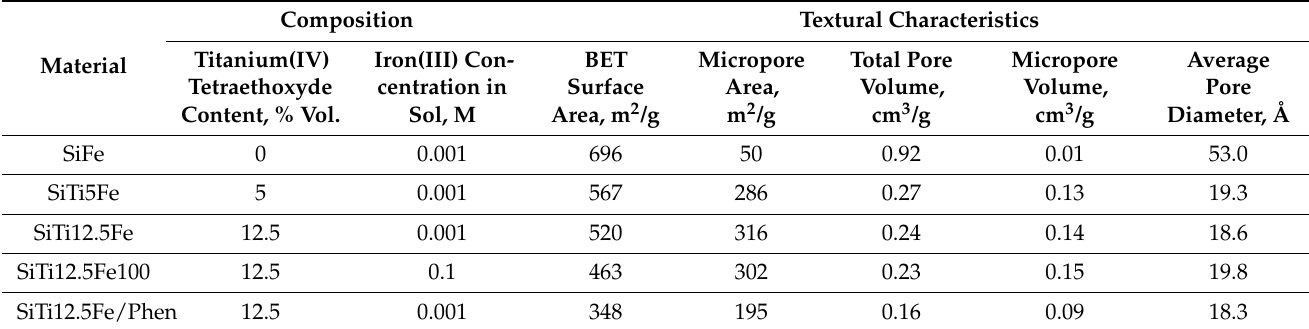
Table 1. Composition and textural characteristics of silica and silica–titania xerogels doped with iron(III). Composition Textural Material